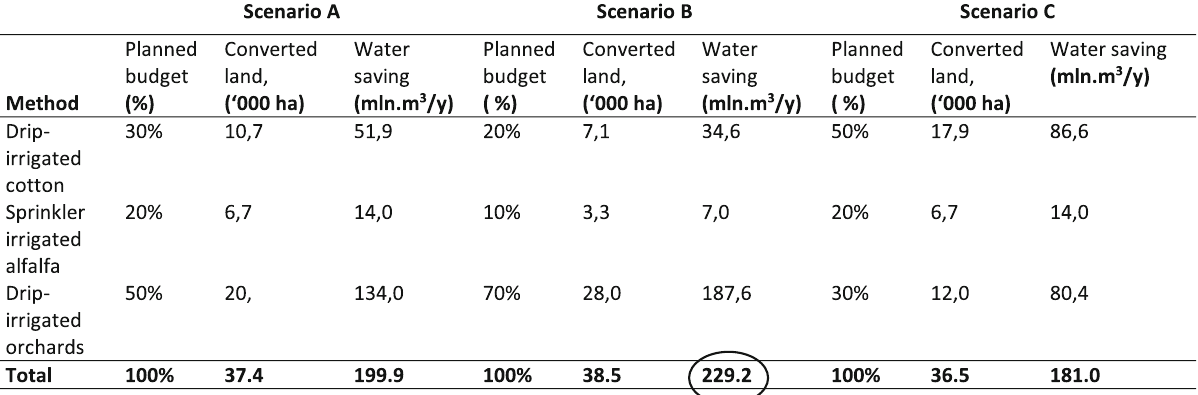
Table 3 Scenarios proposed by the models for water